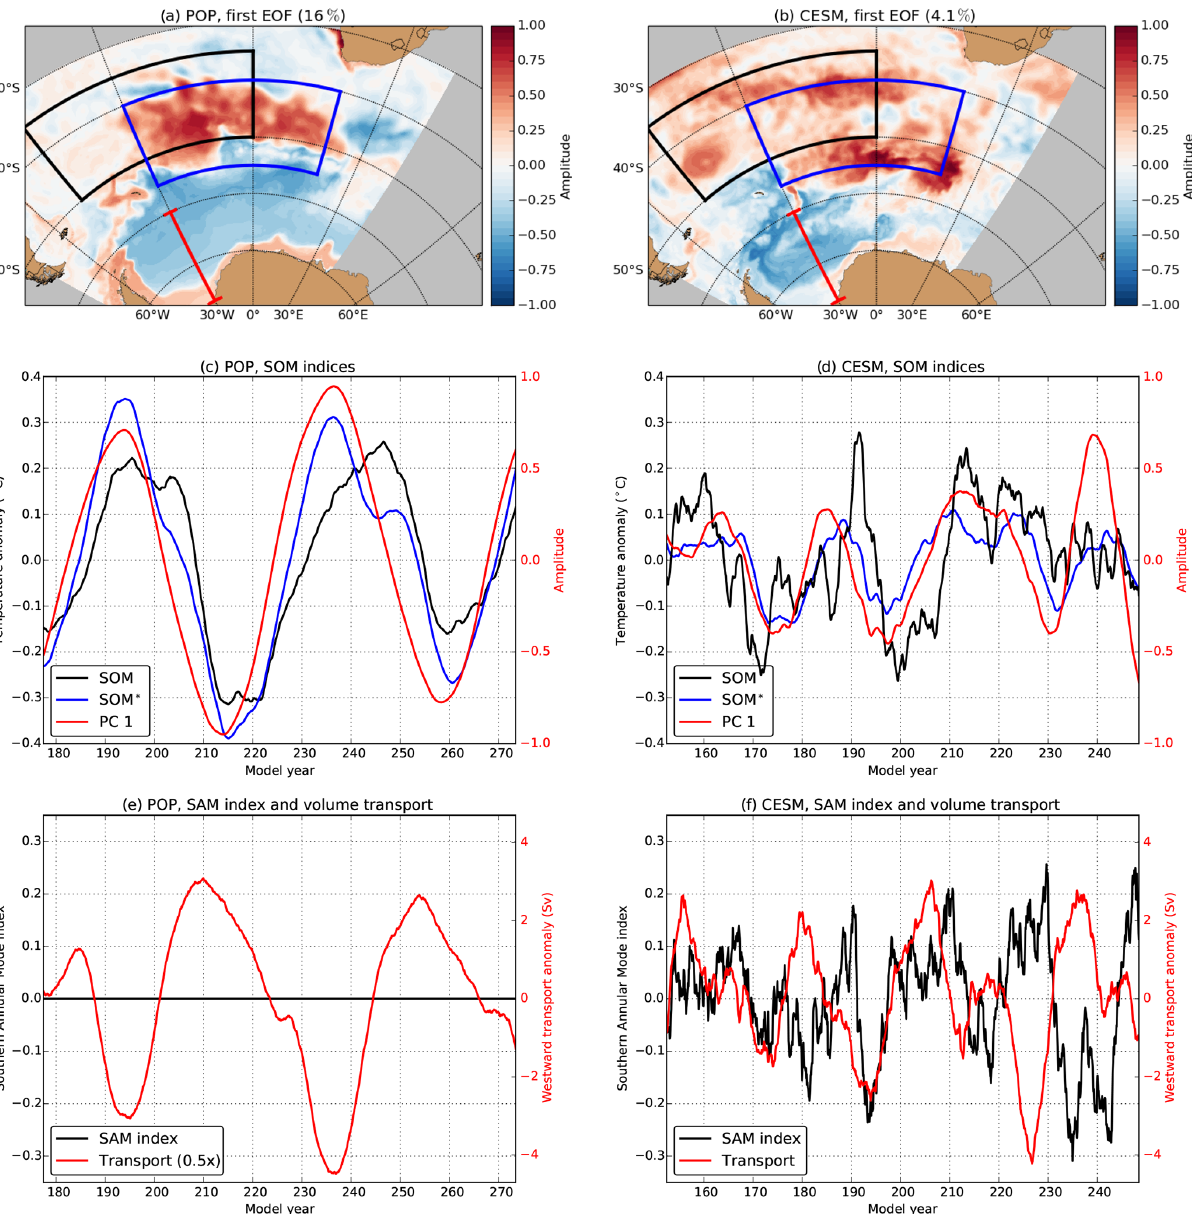
Figure 3. (a, b) The first EOF of the upper 1000m averaged temperature in the Southern Ocean (80–30 ◦ S, 70 ◦ W–40 ◦ E) for the stand- alone POP and for CESM. The black-outlined (blue) region is used to determine the SOM (SOM ∗ ) index. The full-depth westward volume transport is determined over the red section (77–60 ◦ S, 30 ◦ W). (c, d) The SOM index, SOM ∗ index and the first PC (of the upper 1000m averaged temperature field) for the stand-alone POP and CESM. (e, f) The SAM index and westward volume transport anomaly at 30 ◦ W for the stand-alone POP and CESM. The time series in panels (c–f) are quadratically detrended and smoothed with a 60-month running mean. The anomalies of the westward transport are reduced by a factor of 2 for the stand-alone